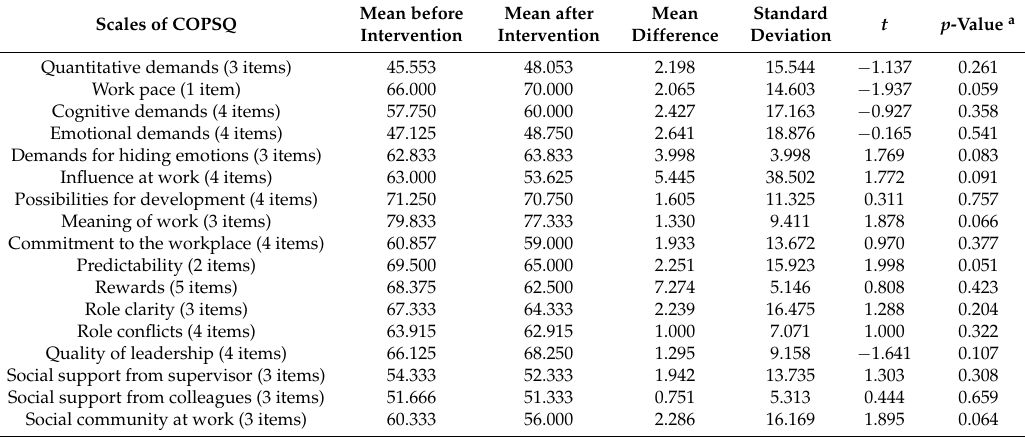
Table 5. Means and standard deviations of scores of different scales of Thai version of the psychosocial questionnaire in the control before and after the intervention ( n =